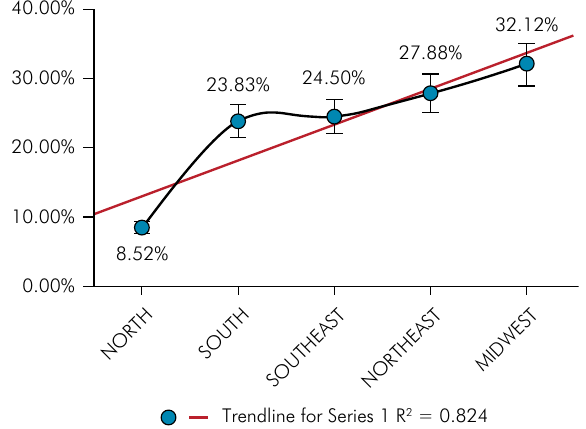
Figure 2. Analysis of percentage reduction in AIHs among